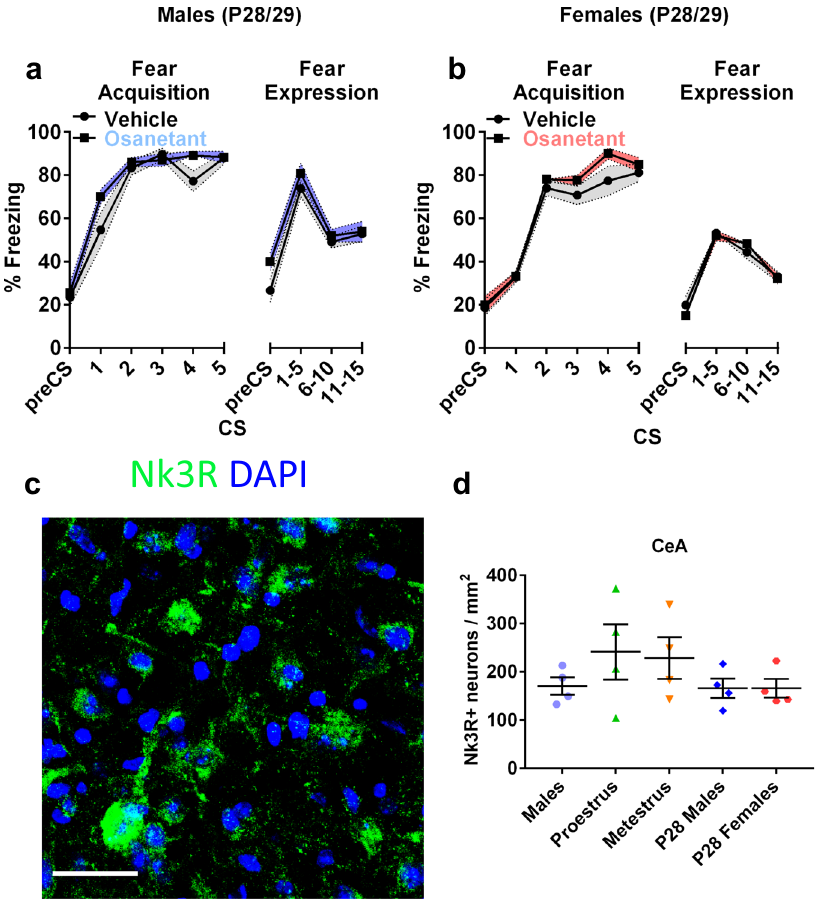
Fig. 2 Systemic injection of osanetant given 30 min after fear acquisition is ineffective in modulating fear memory consolidation in prepubertal male and female mice, which present similar expression of Nk3R-positive neurons compared to adult male and female mice across the estrous cycle. a Effect of osanetant or vehicle administration 30 min after FA in freezing behavior in P28 male ( n = 8 per group) and ( b ) female mice ( n = 8 per group). c Representative confocal image of the Nk3R in the CeA of prepubertal mice. Scale bar = 60 µ m. d Quanti fi cation of Nk3R-positive cells in the CeA of adult and prepubertal males and prepubertal and adult females across the cycle ( n = 4 per group). Data are expressed as mean ± SEM. Main effect treatment, main effect CS, and CSxTreatment interaction were analyzed using repeated measures ANOVA, while NK3R expression was analyzed using non- parametric Krukal – Wallis ’ χ 2